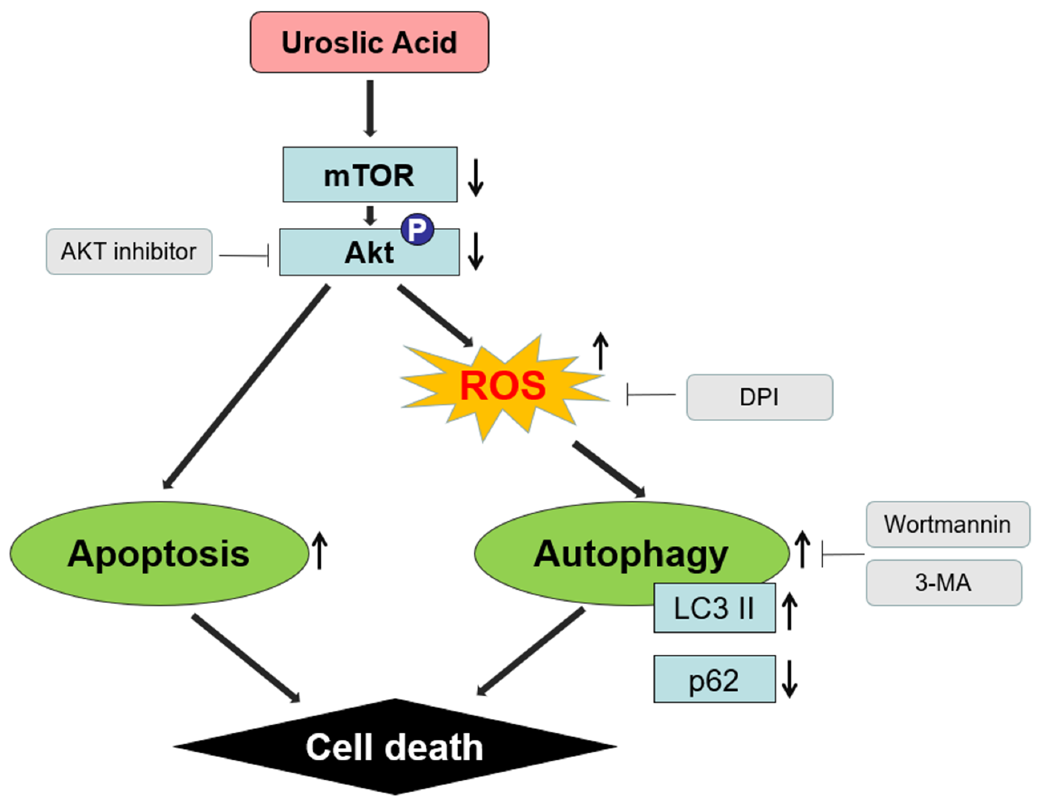
Figure 6. Schematic diagram illustrates the underlying mechanism of UA-induced autophagy through enhanced ROS production via the mTOR/Akt signaling pathway.